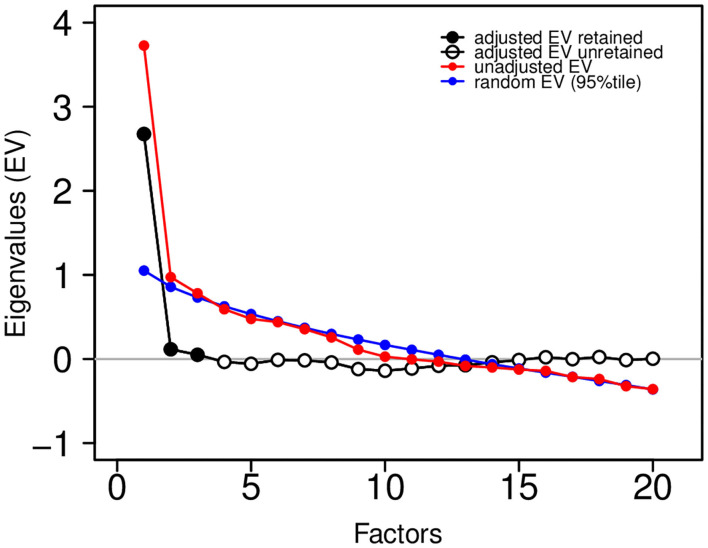
Eigenvalue plot showing unadjusted eigenvalues (in red) and adjusted eigenvalues (in black and white). The factor solution was based on three retained (three adjusted eigenvalues greater than zero). Adjustments were based on the 95th percentile of a random eigenvalue distribution (in blue).